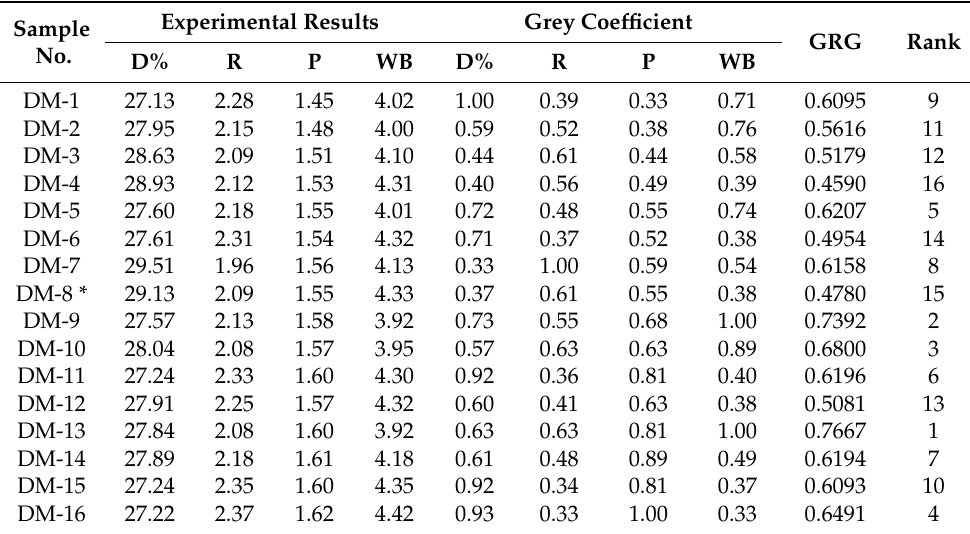
Table 3. Responses from experimental runs and grey relational analysis.